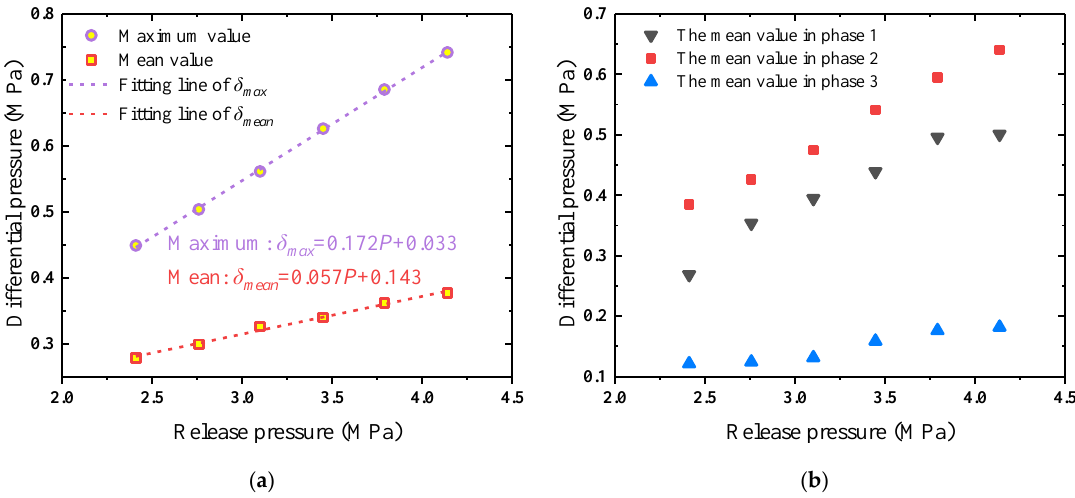
Figure 9. ( a ) The maximum and mean values of differential pressure in the whole process. ( b ) The mean value of differential pressure in each phase.